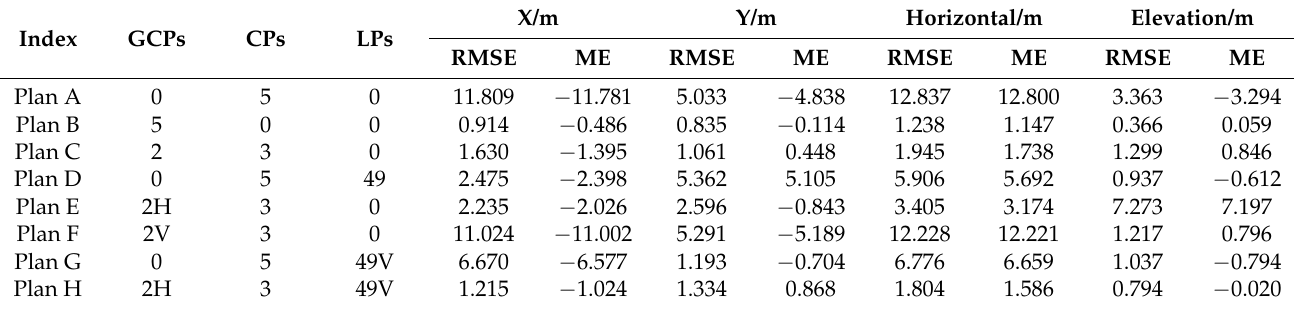
Table 3. Experimental results in the Laos–Thailand border